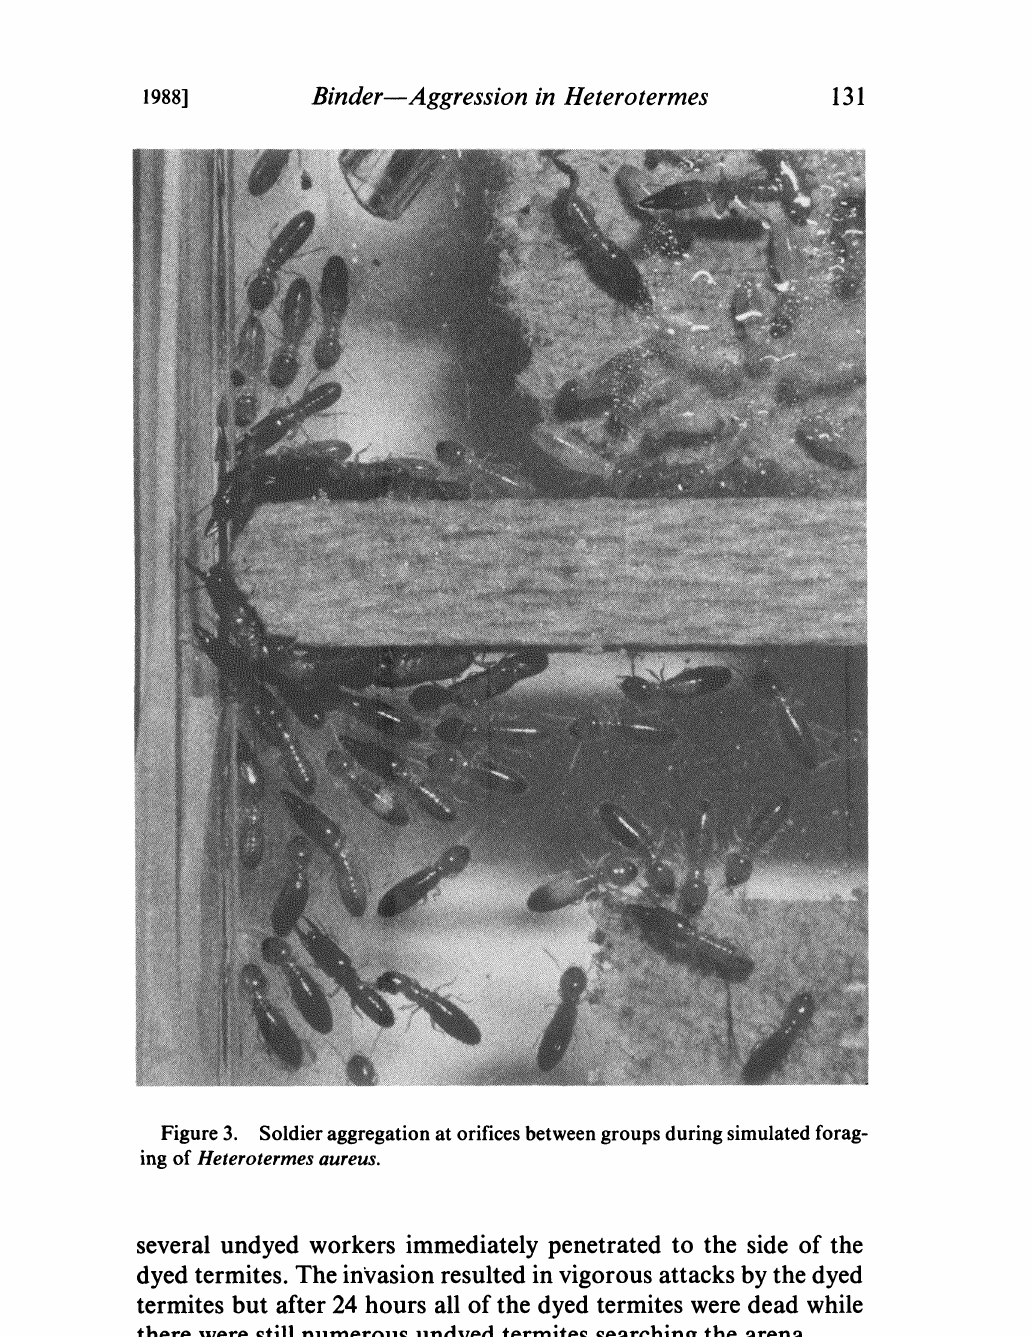
Figure 3. Soldier aggregation at orifices between groups during simulated forag- ing of Heterotermes